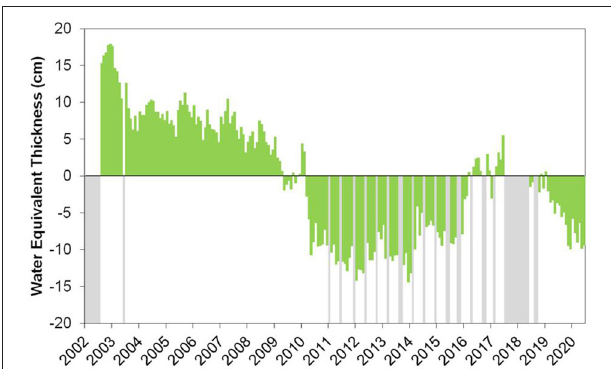
FIGURE 12 | Temporal evolution of the monthly WET anomalies over CWA retrieved by GRACE (2002-2017) and GRACE-FO (2018-2020) missions. Gray bars indicate missing